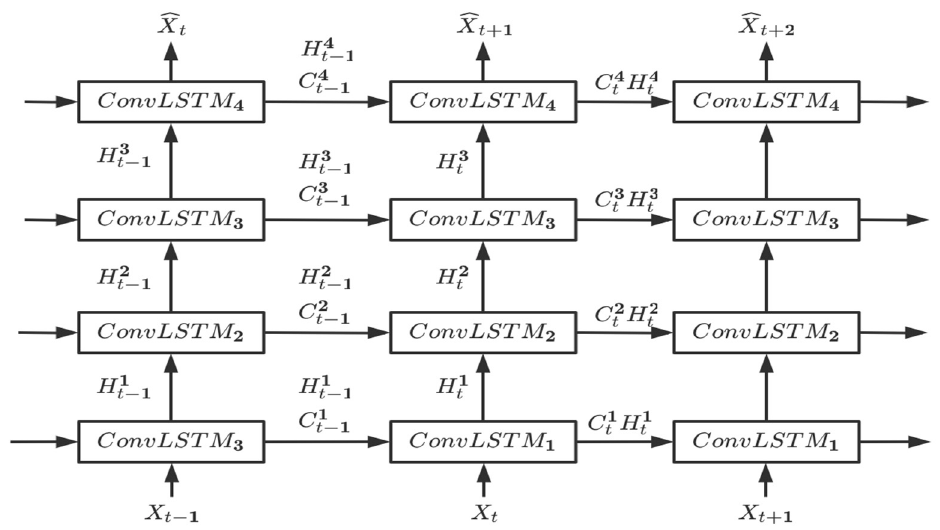
Figure 1. Stacked ConvLSTM recurrent neural network.